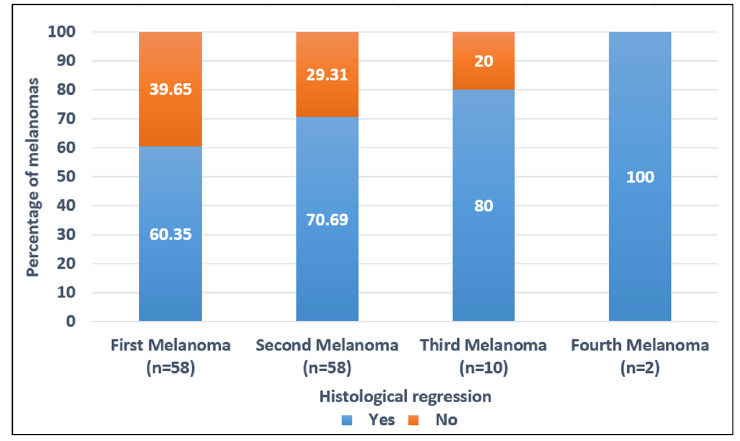
Figure 5. Rate of first and subsequent primary melanomas with histological